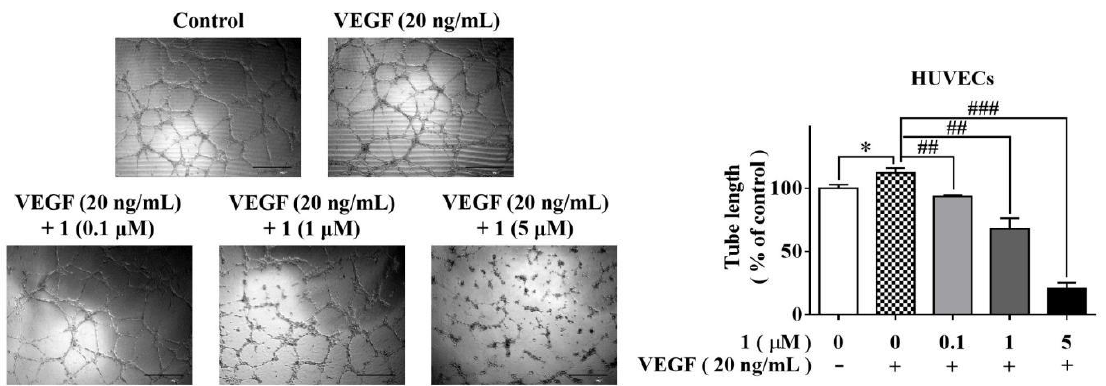
Figure 3. The effect of 1 on tube formation of HUVECs were examined by tube formation assay. ( n = 3, means ± SEM are shown; * p < 0.05, compared with control, ## p < 0.01, ### p < 0.001, compared with VEGF only).